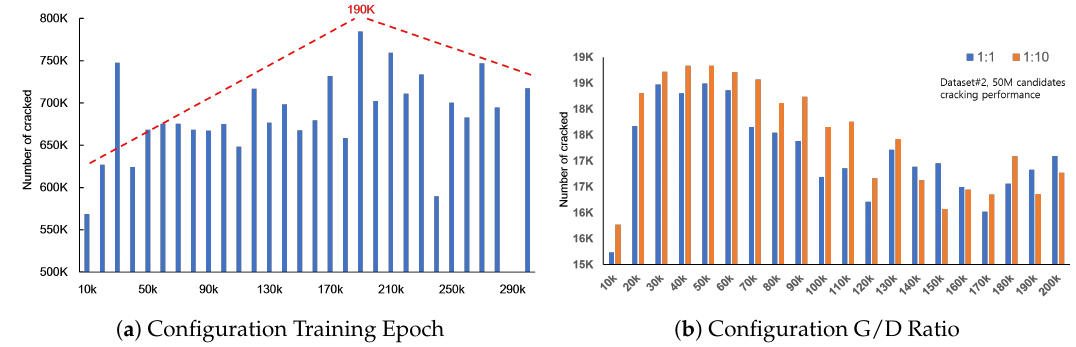
Figure 4. Cracking performance per training epoch: After 190k epochs, the password cracking performance was degraded. Training for too many epochs has a bad effect on relativistic discriminator. Based on the number of cracked passwords, G/D ratio of 1:10 yielded better password cracking